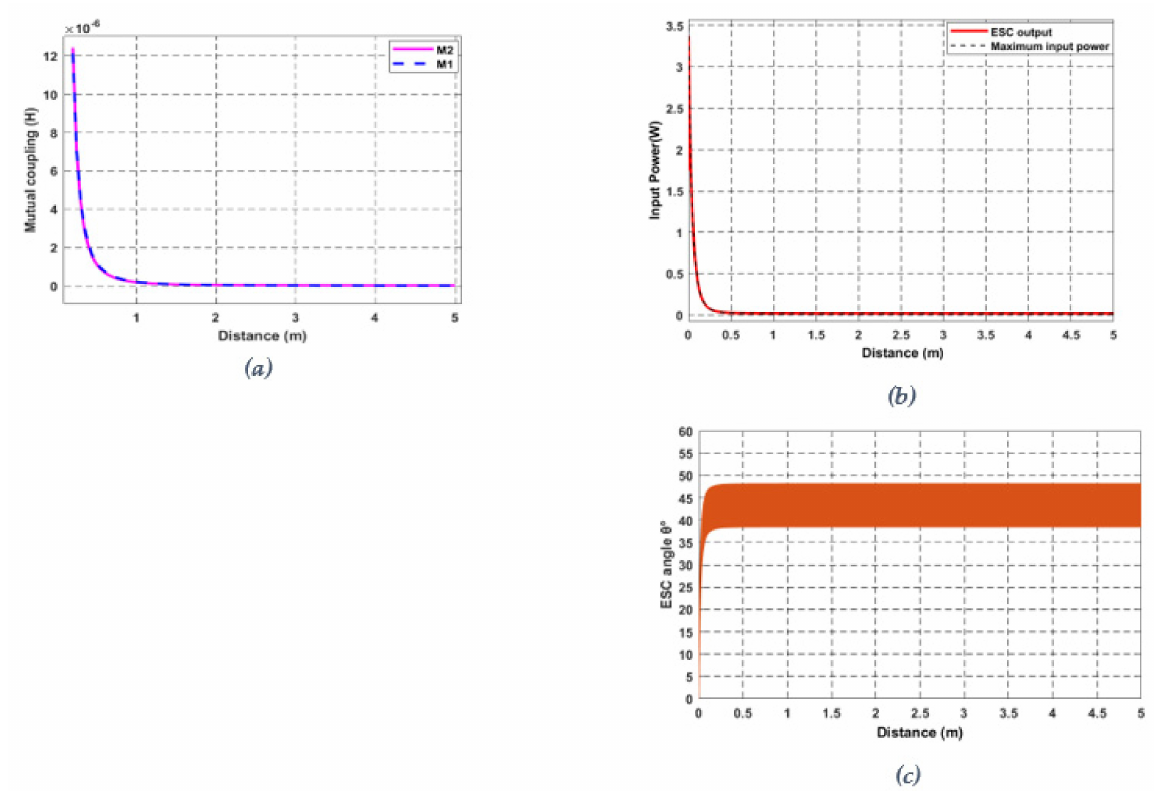
Figure 18. Continuous distance variation of the receiver when α is fixed at 45 ◦ . ( a ) Mutual coupling in terms of the receiver distance variation. ( b ) Input power maximum tracking under a continuous distance variation. ( c ) Optimum magnetic resultant angle θ searched by the ESC when the distance is varying